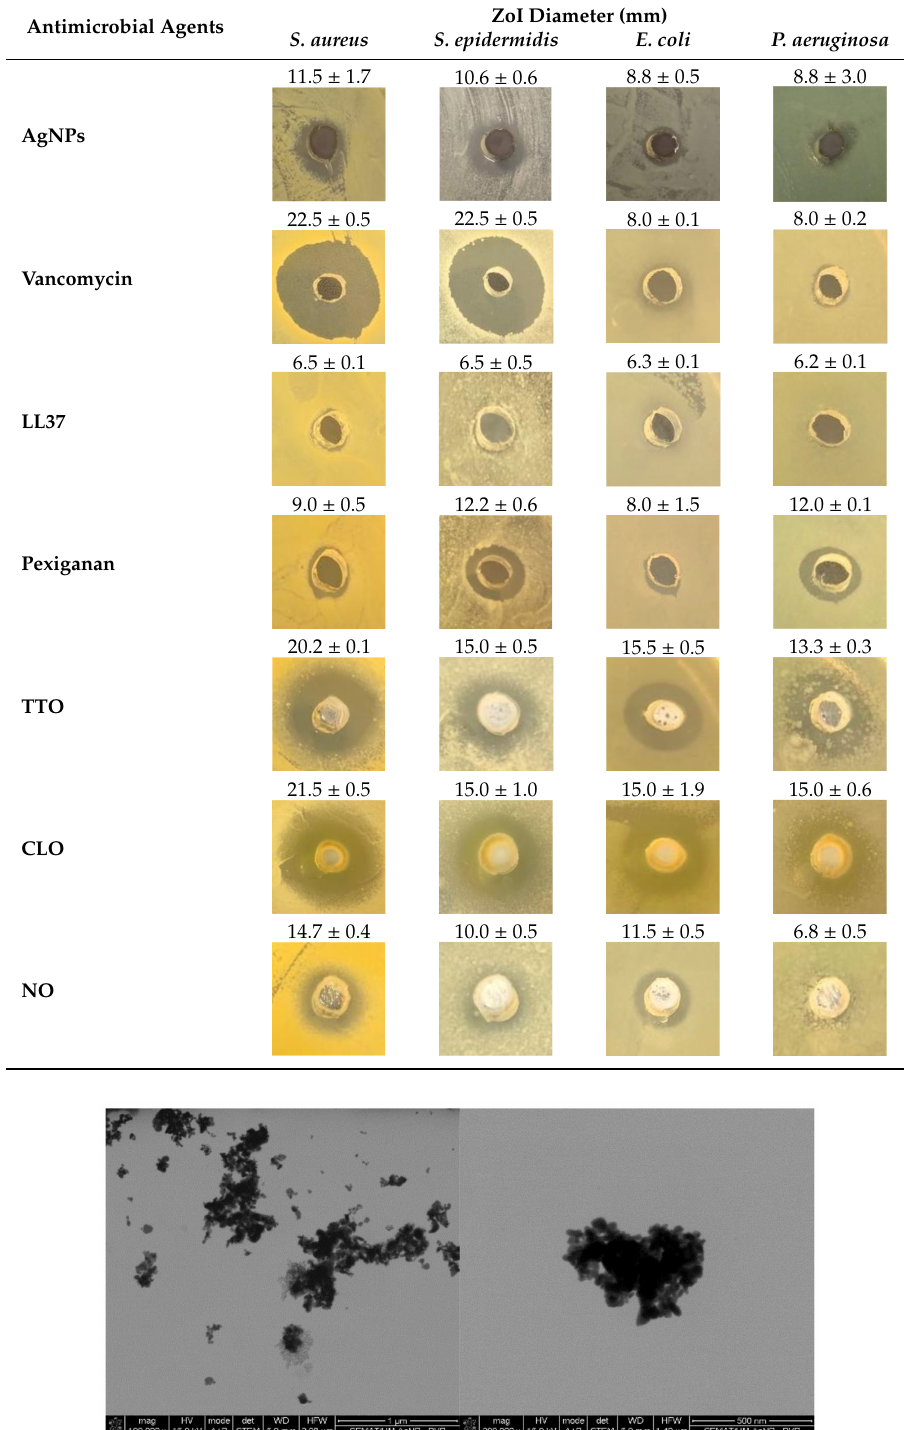
Table 1. Zones of inhibition (ZoI) of selected antimicrobial agents against Gram-positive and Gram-negative bacteria ( n = 3, mean ± standard deviation (SD)). The diameter of the holes (Ø = 6 mm) was included. Images were collected without regard for size proportionality, only being used as representations of the halos formed.